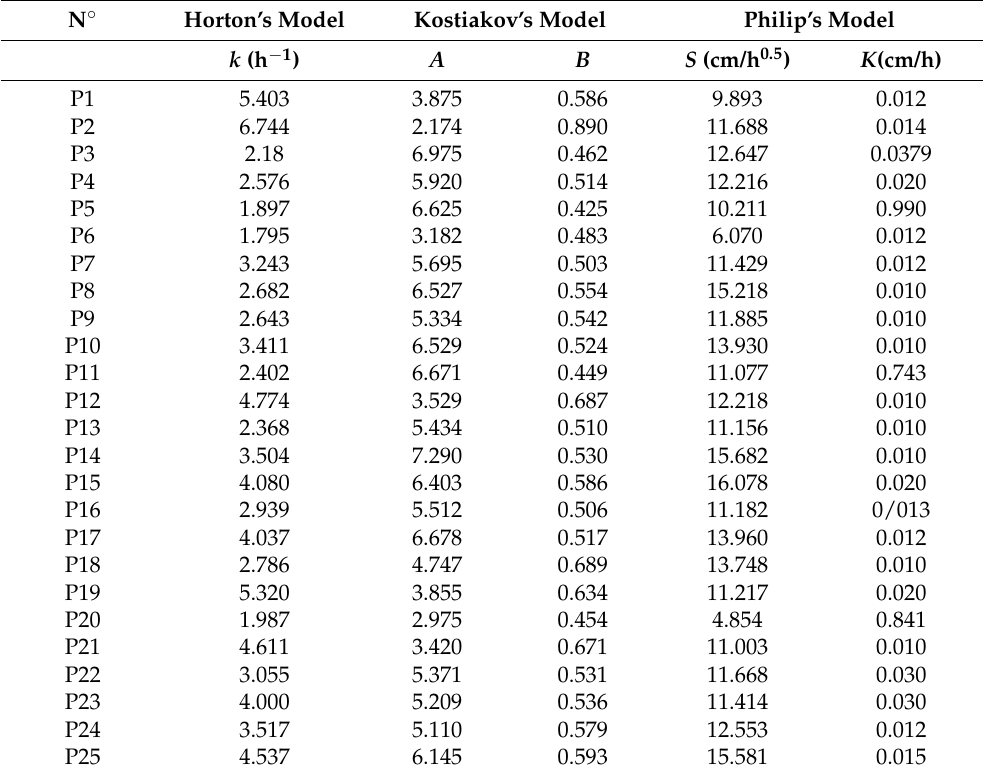
Table 4. Calculated parameters of infiltration models.